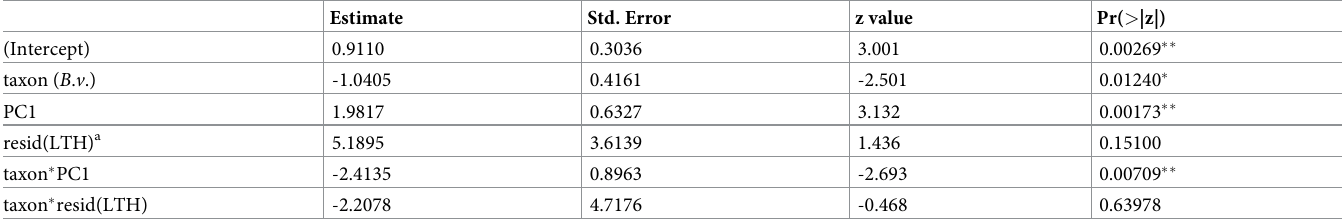
Table 3. Coefficients of the logistic model of survival.